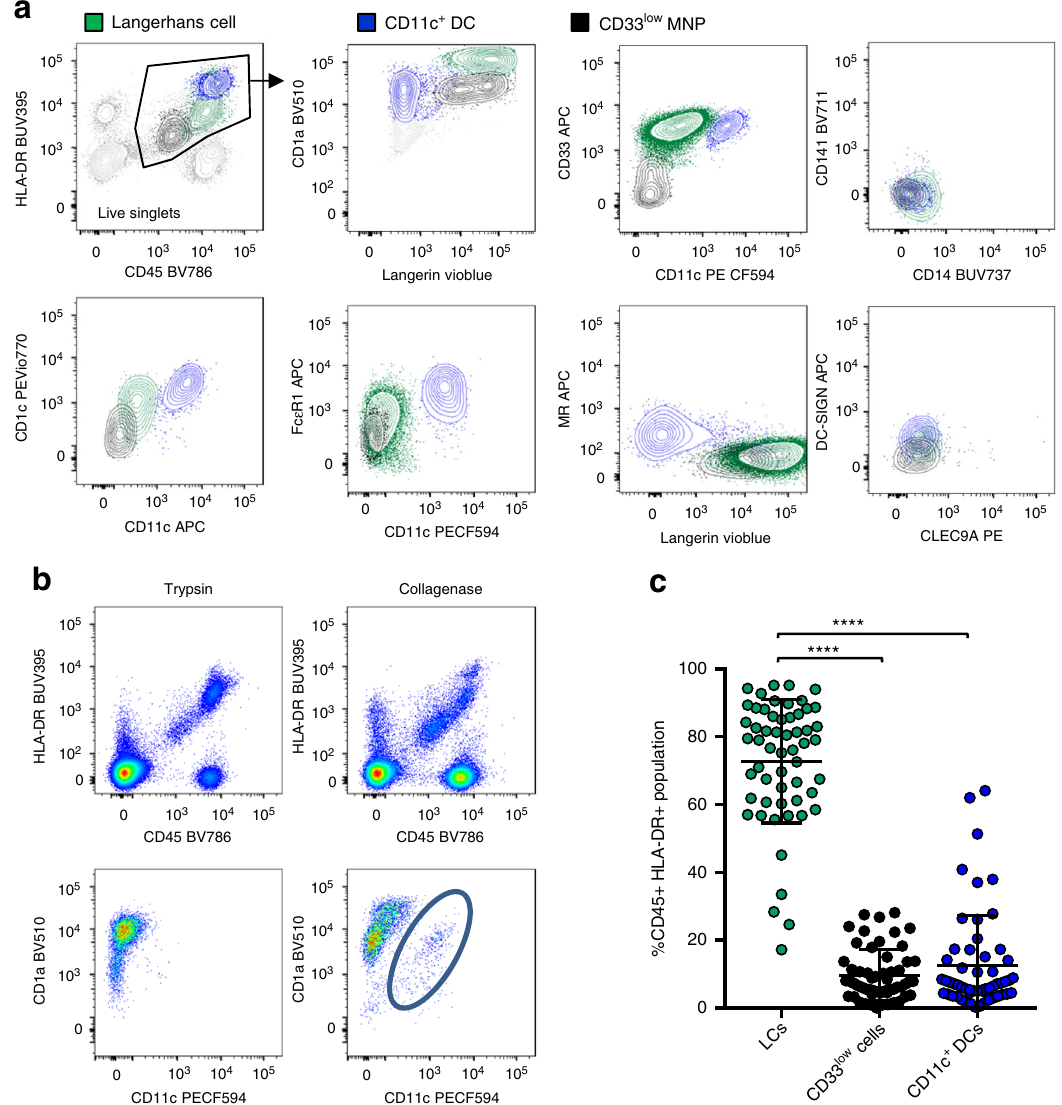
Fig. 1 De fi nition of distinct human epidermal mononuclear phagocytes by fl ow cytometry. Mononuclear phagocytes were liberated from human epidermis using trypsin or Type IV collagenase. a Flow cytometry was used to de fi ne three subsets of CD3 − /CD19epidermal MNPs from collagenase digested tissue (i) Langerhans cells (green) were de fi ned as HLA-DR intermediate , CD1a very high , langerin high , CD33 + , CD11c − , MR − (ii) epidermal CD11c + DCs (blue) were de fi ned as HLA-DR high , CD1a + , langerin low , CD11c + , MR + (iii) epidermal CD33 low cells (black) were de fi ned as HLA-DR low , CD1a + , langerin high , CD33 low , CD11c − , MR − . Representative data of 75 individual donors is shown. b CD11c expression was compared on cells derived from trypsin and collagenase digestion. The blue circle indicates the CD11c + cells detected in collagenase digested tissue that are not observed in trypsin digested tissue. Representative data of fi ve individual donors is shown. c The relative proportion of each subset CD45 + HLA-DR + gate after collagenase digestion was determined and is shown as a mean ± the standard deviation with each dot representing an individual donor. Statistics were generated using the Mann – Whitney test. * p < 0.05; ** p < 0.01; *** p < 0.001; **** p < 0.0001 ( n = 75) next de fi ned the lectin surface expression pro fi les of each epi- or CXCR4. Epidermal CD11c + DCs expressed all the lectins dermal MNP subset using fl ow cytometry and also compared expressed by LCs except for langerin. In addition, and distinct them to dermal cDC2. Furthermore, as LCs have been shown to from LCs, CD11c + DCs expressed CLEC4M (L-SIGN), be infected by HIV, we also measured the surface expression of CLEC10A, CLEC12A and MR as well as Siglec-5 and much the HIV entry receptors CD4, CCR5 and CXCR4 (Table 1 and higher levels of Siglec-9. Consistent with their transcriptional Supplementary Fig. 3). LCs expressed high levels of langerin, pro fi les (Fig. 2) this was a similar pattern of surface expression to CLEC5A and DCIR, moderate levels of DEC205, Siglec-3 (CD33) dermal cDC2 but the two populations did differ in that dermal and Siglec-9, low levels of CD4 and CCR5, and did not express cDC2 expressed low levels of CLEC8A, Siglec-1, Siglec-6 and MR, DC-SIGN or CXCR4. Other than expressing lower levels of Siglec-16 and much higher levels of MR. Importantly, we also Siglec-3 (CD33), epidermal CD33low cells showed an almost observed that epidermal CD11c + DCs expressed much higher levels of the HIV entry receptor CCR5 than any other MNP identical pattern of lectin receptor expression to LCs. However (including dermal cDC2). they did not express any of the HIV entry receptors CD4, CCR5 NATURE COMMUNICATIONS| (2019) 10:2759